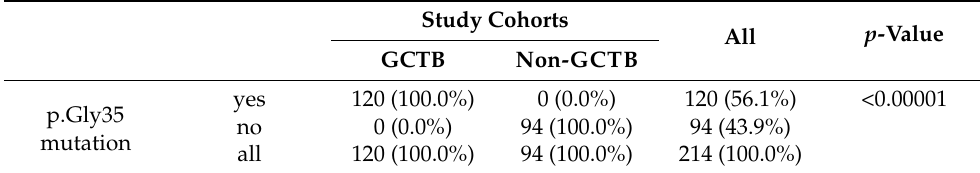
Table 2. Results of direct Sanger sequencing.